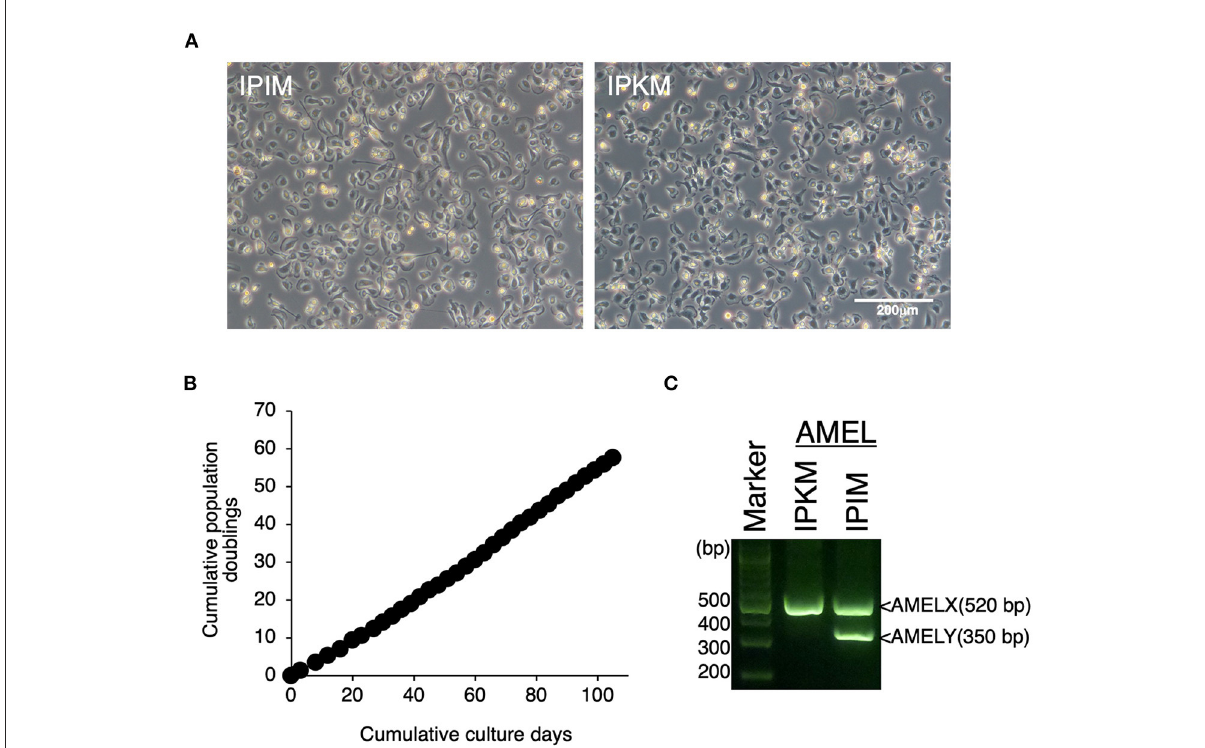
FIGURE2 Establishment of IPIM and comparison of their features with IPKM. The morphologies of IPIM and IPKM were observed under a phase-contrast microscope (A) . The cumulative population doublings of the IPIM were plotted against the duration of the culture period (in days) (B) . PCR-based sex identification based on the porcine amelogenin ( AMEL ) genes was performed using genomic DNA from the IPIM and IPKM, and PCR products derived from AMELX (520 bp) and AMELY (350 bp) were analyzed by agarose gel electrophoresis (C)